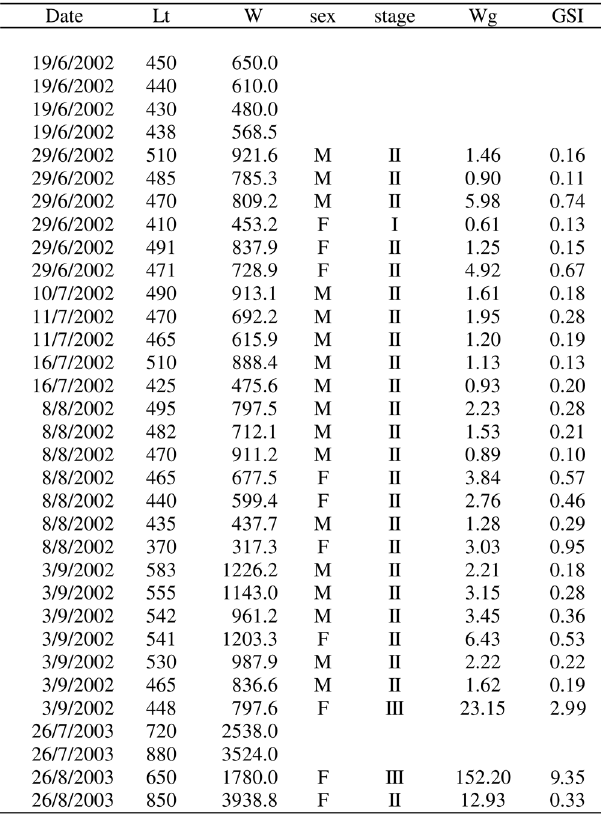
Table 1. Date, total length (LT, mm), weight (W, g), sex (M, male; F, female), maturation stage (I, immature; II, developing virgin or recovering-spent; III, ripe; IV, spent), gonad weight (Wg, g), and gonadosomatic index (GSI %) of Clarias gari- epinus collected in lagoa Encantada, Ilhéus,